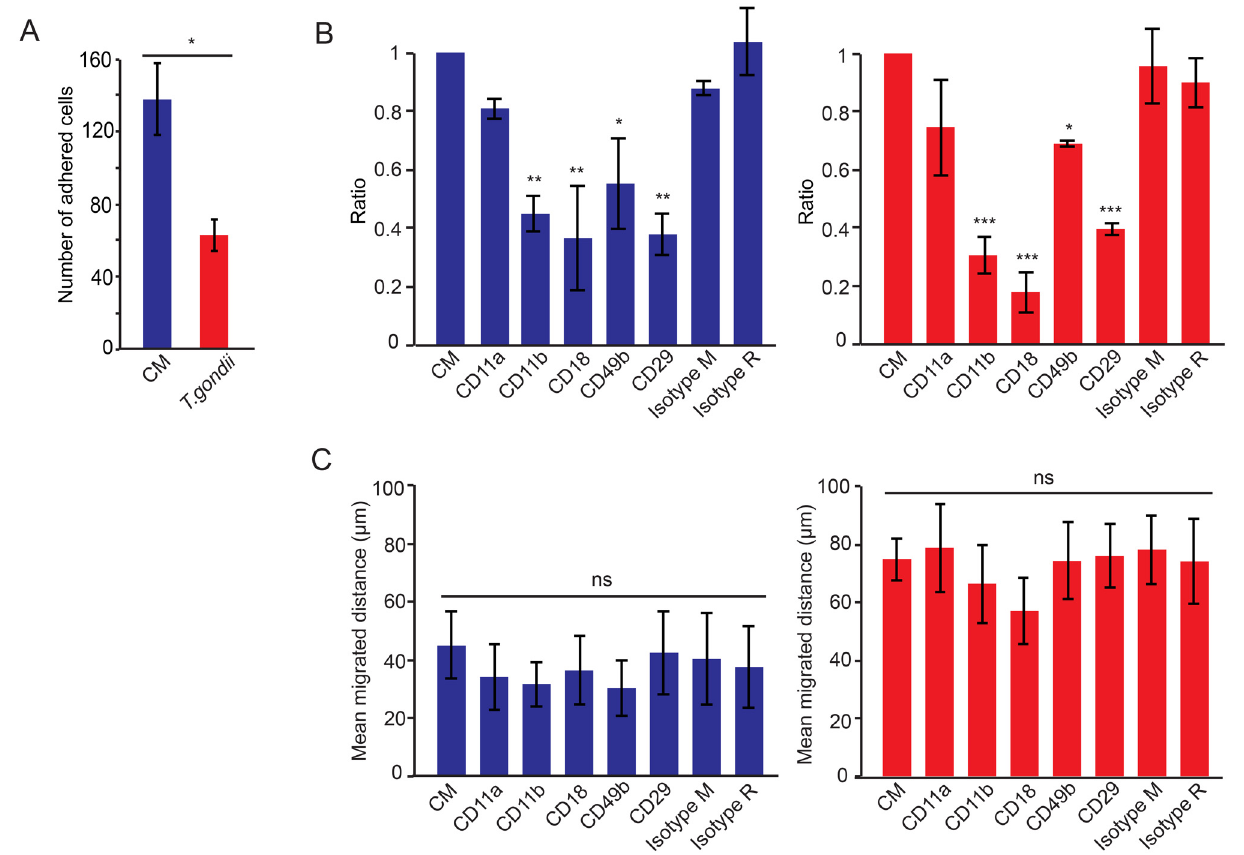
Fig 4. Adhesion and migration of Toxoplasma -infected DCs in the presence of integrin-blocking antibodies. ( A ) Bar graph shows average number of adhered cells per 100 mm 2 ( ± SD) for unchallenged DCs (CM) and Toxoplasma -challenged DCs ( T . gondii , PRU-RFP type II , MOI 3, 4h) as indicated under Materials and Methods ( * : P < 0.05; Paired t- test, Holm´s correction).( B ) Bar graphs show the ratio of adhered cells treated with blocking antibodies compared to cells in CM from 3 donors. Unchallenged DCs (left/blue) and DCs challenged with T . gondii (right/red, PRU-RFP, MOI 3, 4h) were exposed